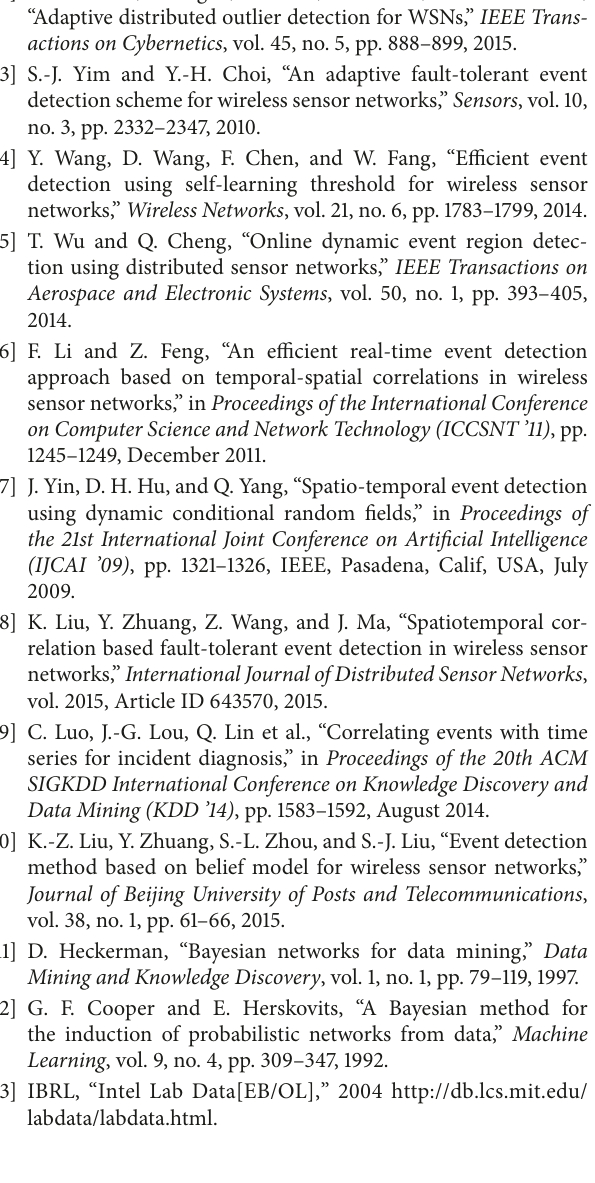
Table 2: Running time of five